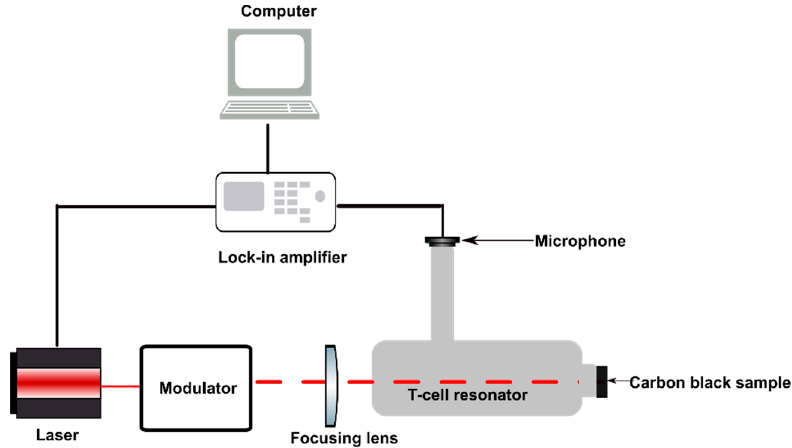
Figure 1. Schematic of the experimental setup.